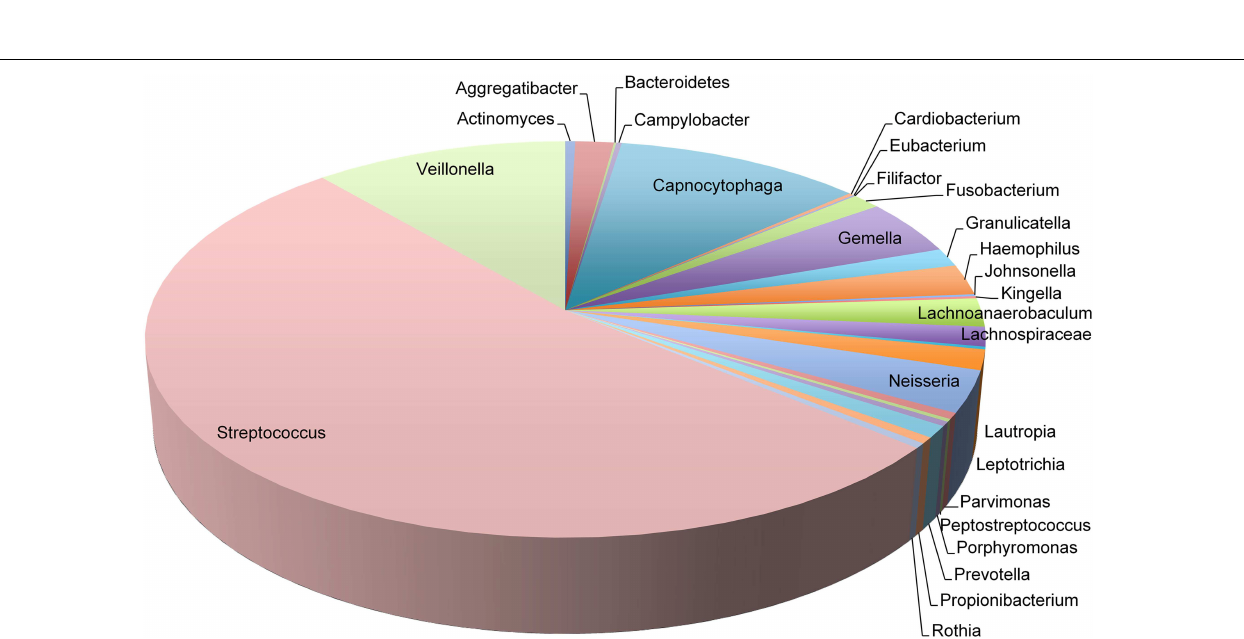
FIGURE 2 | Transcript abundance of representative genera in dental plaque biofilms. Pie chart representing the proportions of transcripts mapping to 27 genera observed in 19 twin pairs.